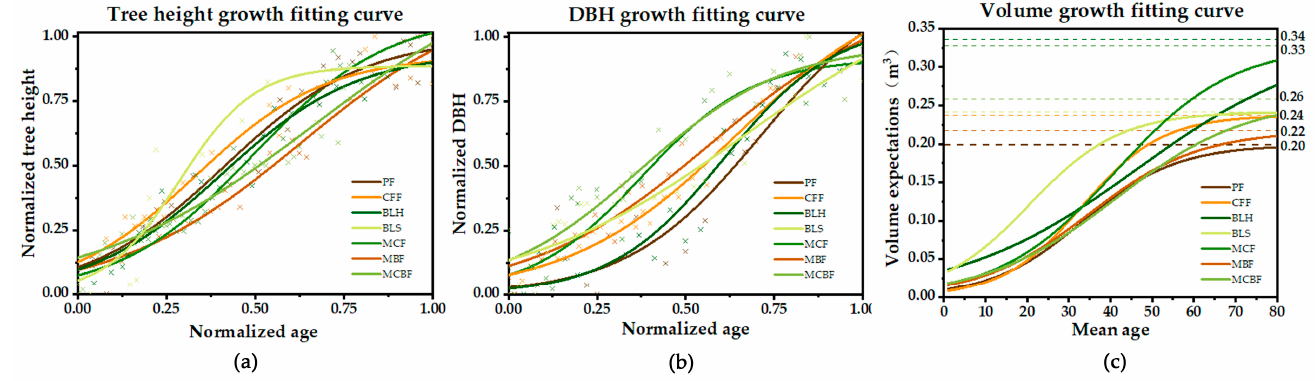
Figure 2. Fitting the growth model of accumulation volume of the forest types in Lushan City. ( a ) shows the tree height-standardized age fitting relationship; ( b ) shows the DBH-standardized age fitting relationship; ( c ) shows the accumulation volume expectation-mean age fitting relationship after random simulation. ( a – c ) compare the relative tree height, relative DBH, and accumulation volume with age curves of different forest types, respectively, which illustrates that the Logistic function has a good fitting effect and also describes the differences between the curves of different forest types, fully reflecting the growth characteristics of forest types in Lushan City. (The points in the graph were forest patches sampling in FMID